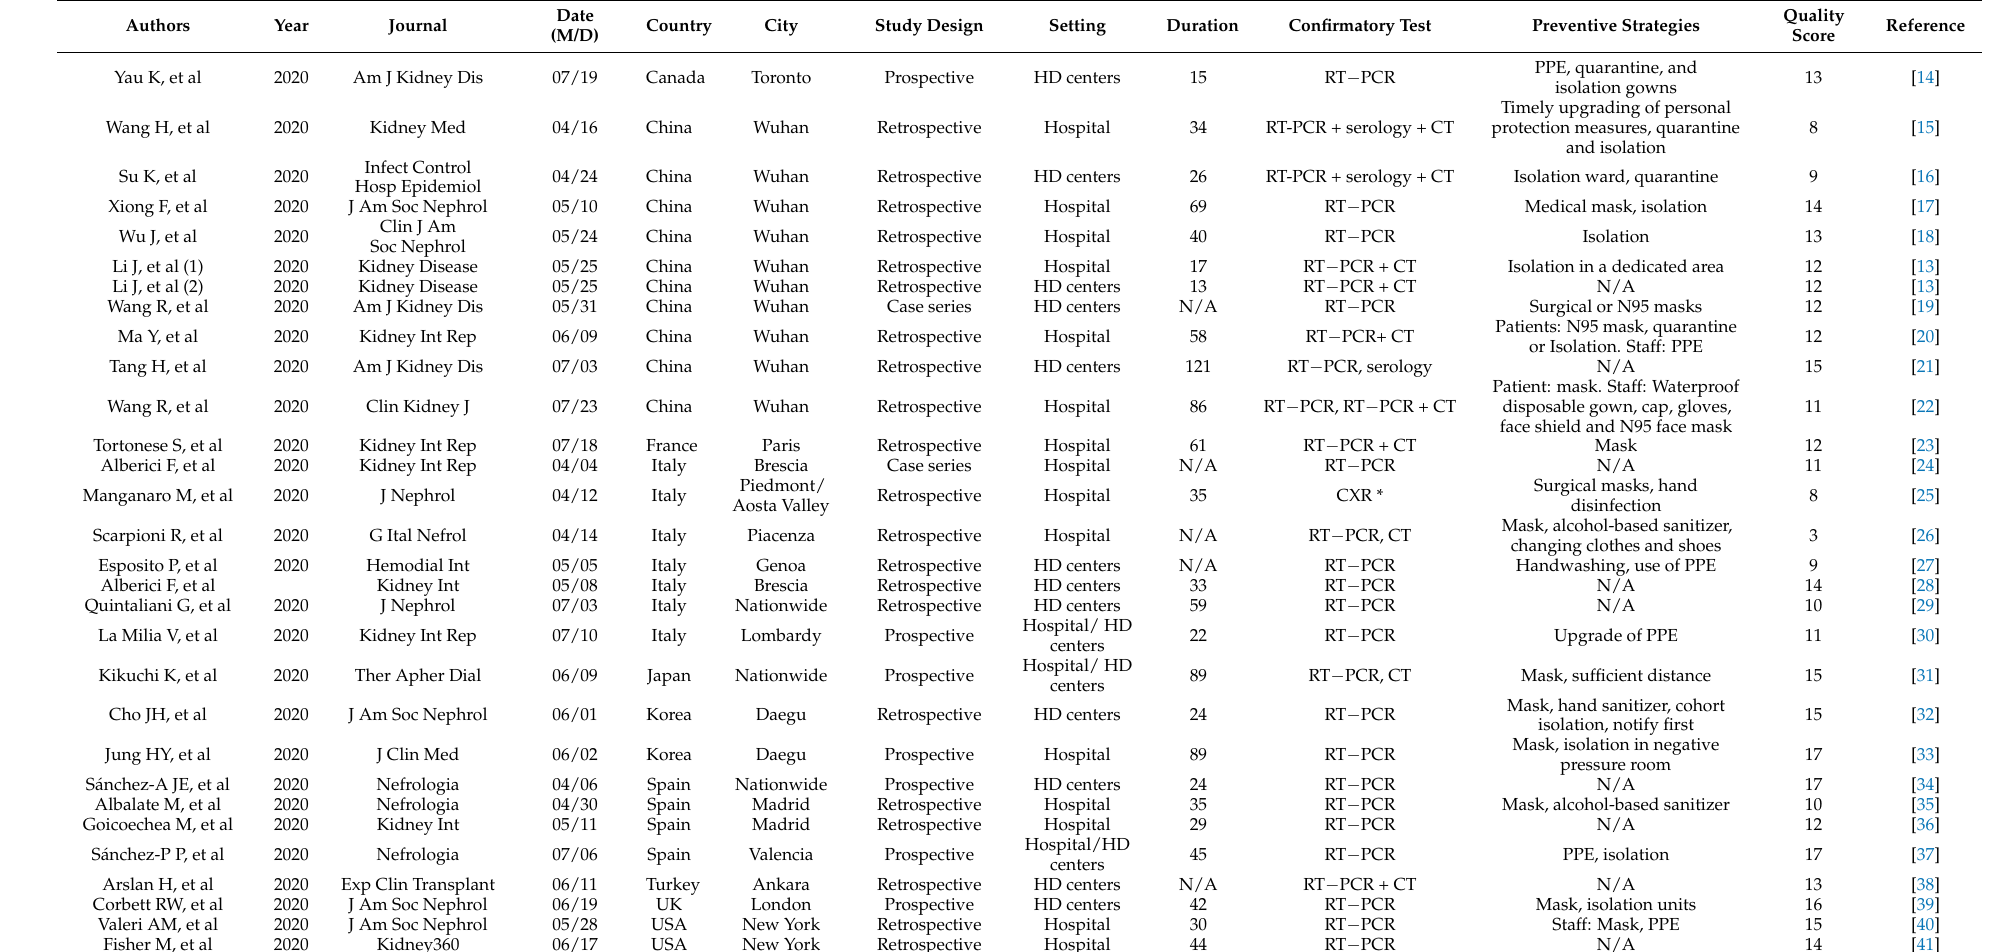
Table 2. Characteristics of studies related to COVID-19 infection in hemodialysis